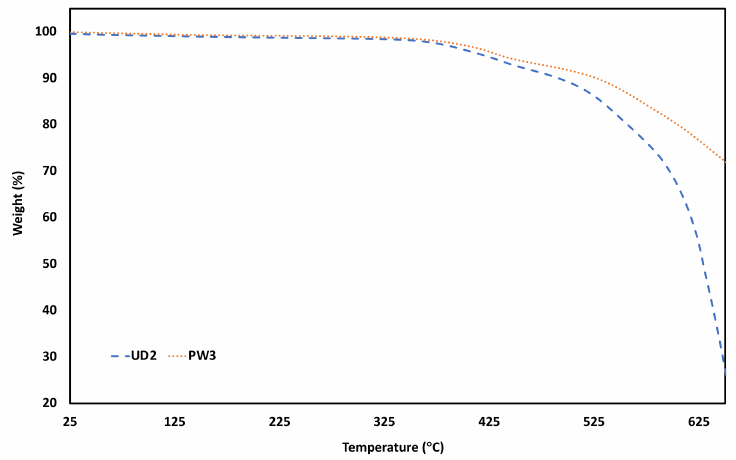
Figure 3. Thermogravimetric analysis (TGA) of manufactured PT 30 composites with UD and PW fibers in an air